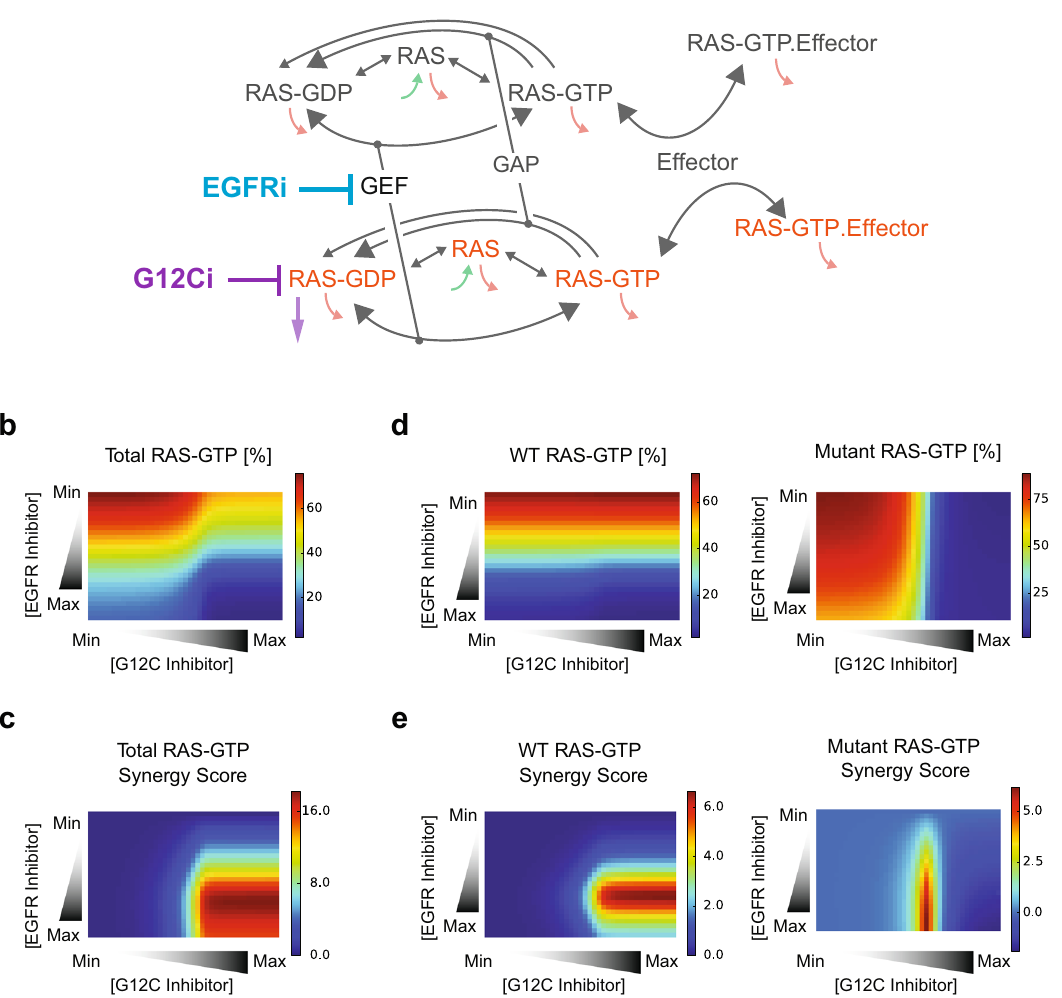
Fig. 2 Mathematical modeling of KRAS G12C inhibition by the KRAS G12C and EGFR inhibitors fi nds the biophysical properties of the RAS network proteins and the RAS and EGFR inhibitors are suf fi cient to explain the co-targeting of wild-type and mutant RAS. a Schematic of model of RAS regulation and KRAS G12C inhibition. Arrow colors indicate the type of reactions: gray, biochemical reactions that regulate the RAS nucleotide binding state; green, RAS production; red, RAS degradation. b Computational model-predicted levels of total RAS-GTP for the combination of KRAS G12C inhibition and EGFR inhibition. c Computational model-predicted Excess over Bliss (EOB) synergy scores based on predicted total RAS-GTP for the combination of KRAS G12C inhibition and EGFR inhibition. d Model-predicted levels of mutant RAS-GTP and WT RAS-GTP for the combination of KRAS G12C inhibition and EGFR inhibition for a modeled KRAS G12C heterozygous network. e Model-predicted EOB synergy scores based on predicted mutant RAS-GTP levels and WT RAS-GTP